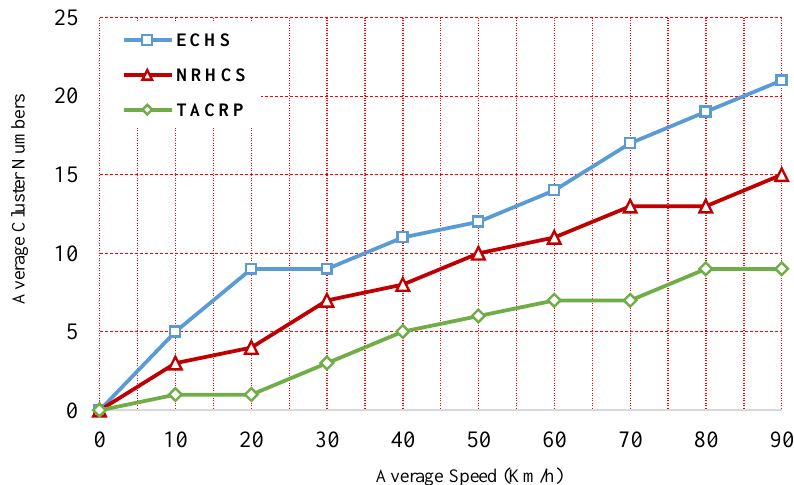
Figure 12. Average Cluster Number Calculation.